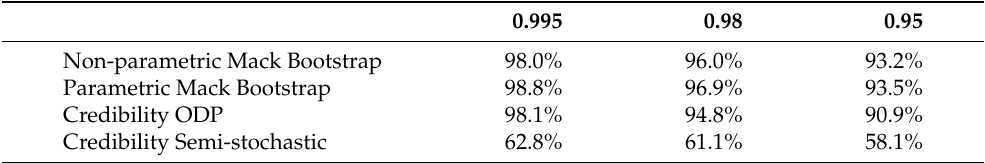
Table 3. Which actual VaR does the estimated VaR approximate if the underlying model is log-normal.